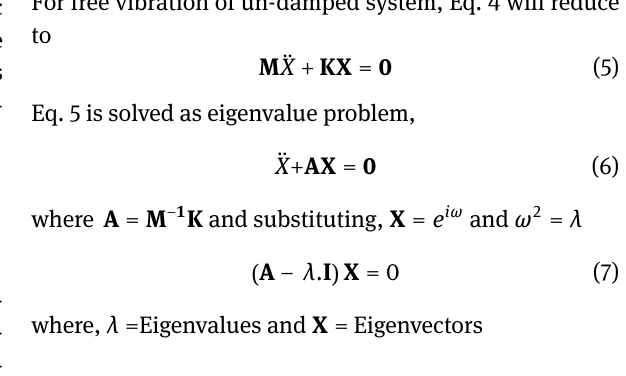
Metallic Structure θ 1